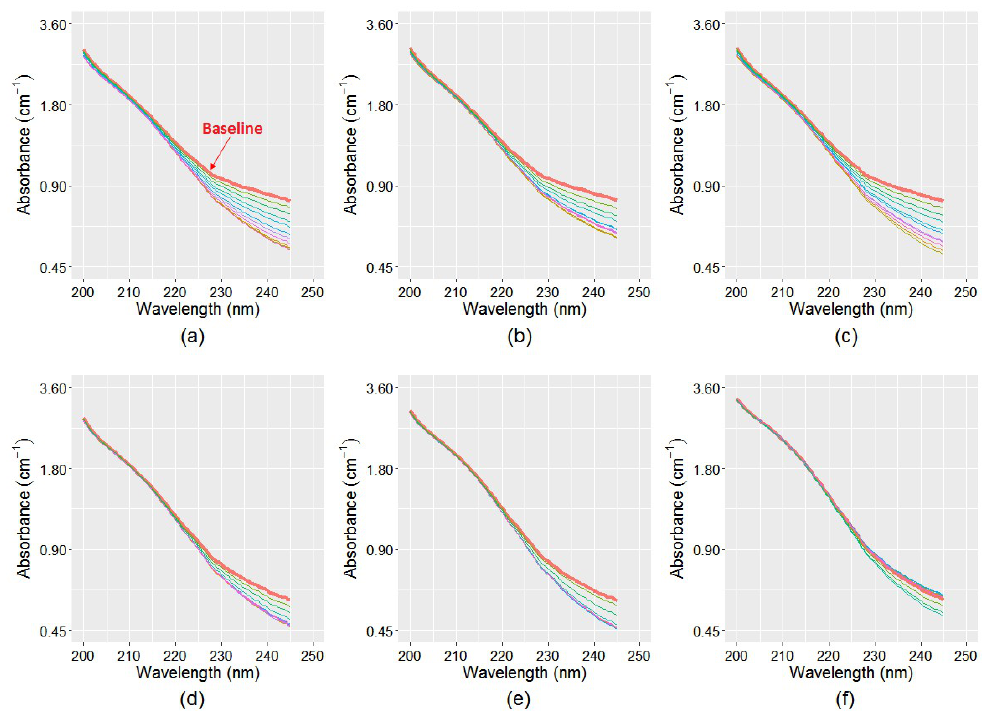
Figure 6. Estimated spectra without the influence of NO x − absorbances for the six samples for a period of eight weeks: ( a ) TB-WTP unprocessed sample; ( b ) TB-WTP 0.22 μm filtered sample; ( c ) TB-WTP enhanced sample; ( d ) Meningie unprocessed sample; ( e ) Meningie 0.22 μm filtered sample; and ( f ) Meningie enhanced sample. Spectral change is assumed to be caused by monochloramine decay only. Compared to Figure 5, the subsequent spectra in all samples in Figure 6 do not cross the baseline, as no NO (cid:2934) − absorbances are considered.